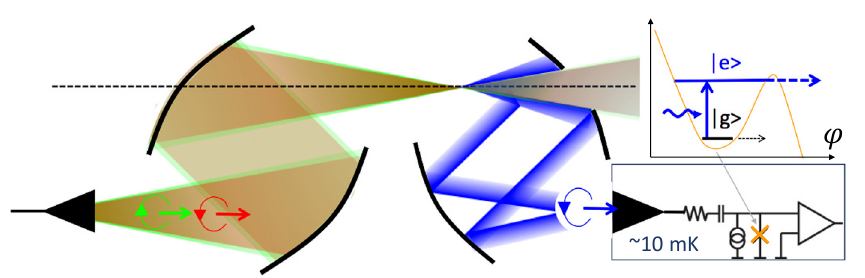
Figure 2 . Conceptual setup of the simulated radar collider and the detection of signal photons. Two circularly polarized coherent beams for creation (green, left-handed) and stimulation (red, right-handed) are combined and focused along a common optical axis. Signal photons (blue, right- handed) are emitted via the exchange of a pNGB. Around the focal plane, only signal photons are partially re(cid:13)ected and collimated by a dichroic parabolic mirror with a hole through which intense GHz beams can escape the detection system, both to avoid adding thermal background sources and to avoid picking up atomic four-wave mixing processes from the upstream mirror surfaces as well as from residual gases in the focal spot, because these background photons are expected to be con(cid:12)ned within the incident angles of the two beams. These peripherally emitted signal photons are focused into the detector element. The detector consists of a signal photon counter. For sensing GHz photons, for instance, a reasonable candidate is a Josephson-junction sensor based on a pulse- current-biased phase-qubit [11]. The bias instantaneously forms a potential, illustrated in the inset, as a function of the phase di(cid:11)erence ’ between two superconductors sandwiching an insulator gap. When a GHz-photon is absorbed in one of the two superconductors, the energy state of a Cooper pair transits from the ground state j g i to an excited state j e i , which drastically increases the probability for the Cooper pair to tunnel to the neighboring superconductor though the